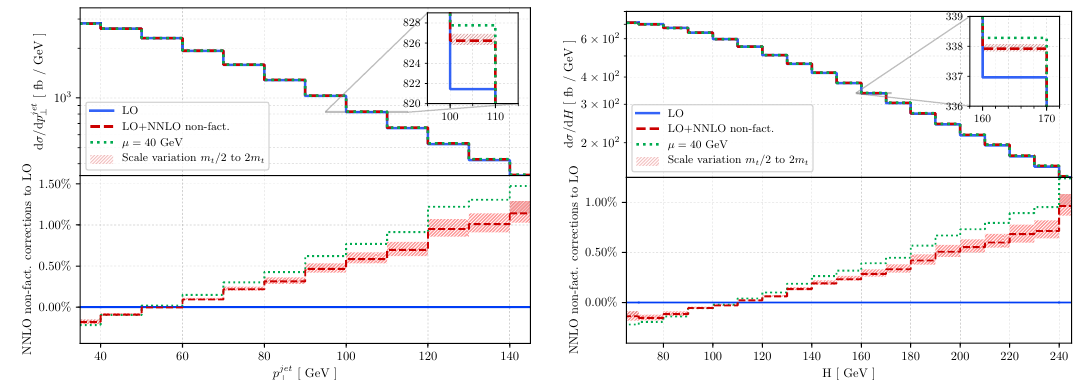
(b) Distribution of the sum of transverse mo- (a) Distribution of the leading-jet transverse mo- menta H . mentum. Figure 5. Distributions of the leading-jet transverse momentum (left) and of sum of transverse momenta H defined in eq. (5.3) (right). LO distributions are marked with a blue, solid line, while red, dashed lines correspond to our predictions for LO+NNLO distributions at µ = m t . The scale is variated between µ = m t / 2 and µ = 2 m t . The green, dotted line corresponds to the scale µ = 40 GeV. Lower panes show the ratio of non-factorisable corrections to LO distributions. See text for further